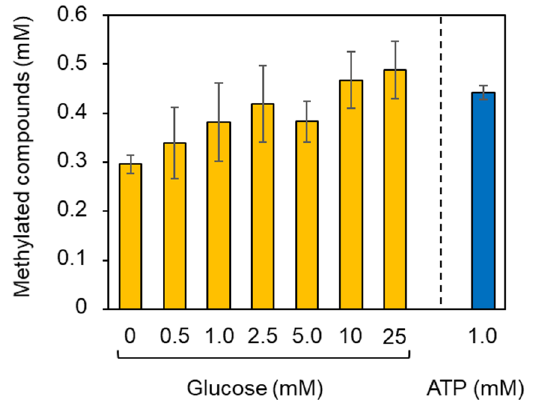
Figure 5. Methylation reaction using glucose as a carbon / energy source for ATP regeneration. The methylation reaction of esculetin was performed for 18 h using OMT-MDH-MetF / ∆ metJ cells with various concentration of glucose instead of ATP (orange bars). The methanol concentration was fixed at 100 mM. The result obtained by 1.0 mM of ATP addition (blue bar) was also shown as a control. Data bars represent the mean ± standard deviations for three independent experiments.